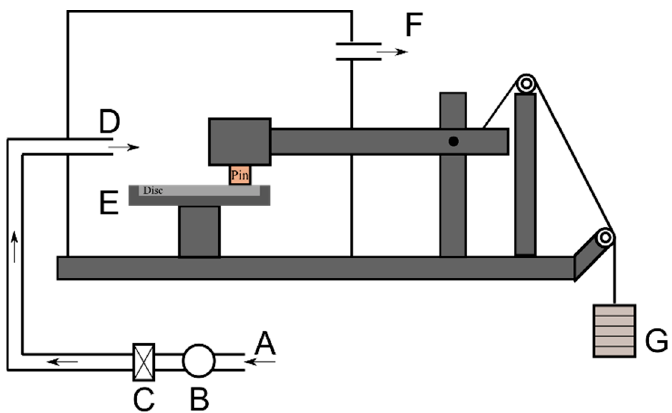
Figure 1. Testing apparatus setup. A: Ambient air; B: Fan; C: HEPA filter; D: Air introduced in the chamber; E: Disc/Counterface; F: Air outlet to the OPS; G: Weights.